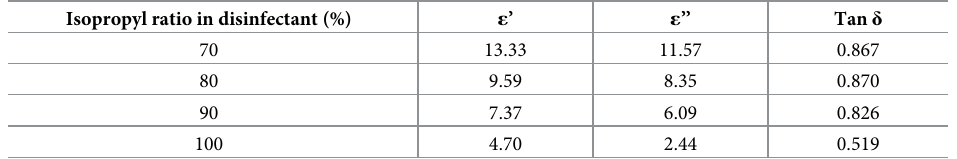
Table 2. Dielectric parameters and loss tangent values for the disinfectant-isopropyl liquid.